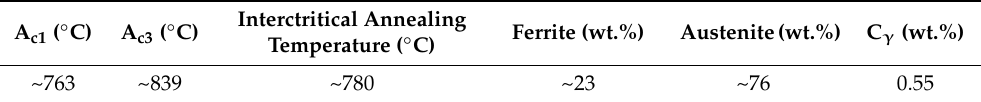
Table 2. Intercritical annealing